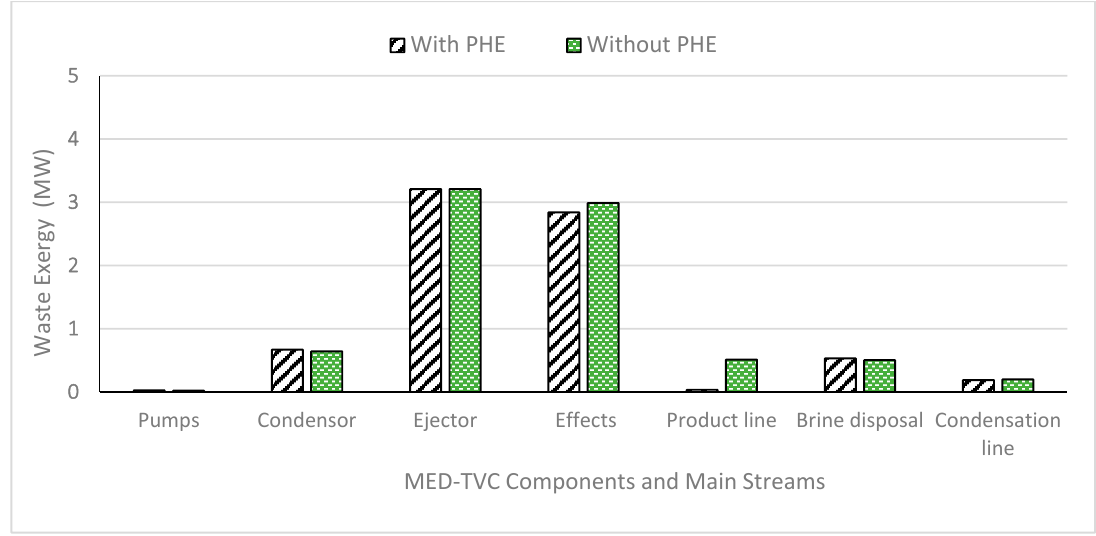
Figure 10. Waste exergy for all MED-TVC components and main streams for both preheat and non-preheat modes.